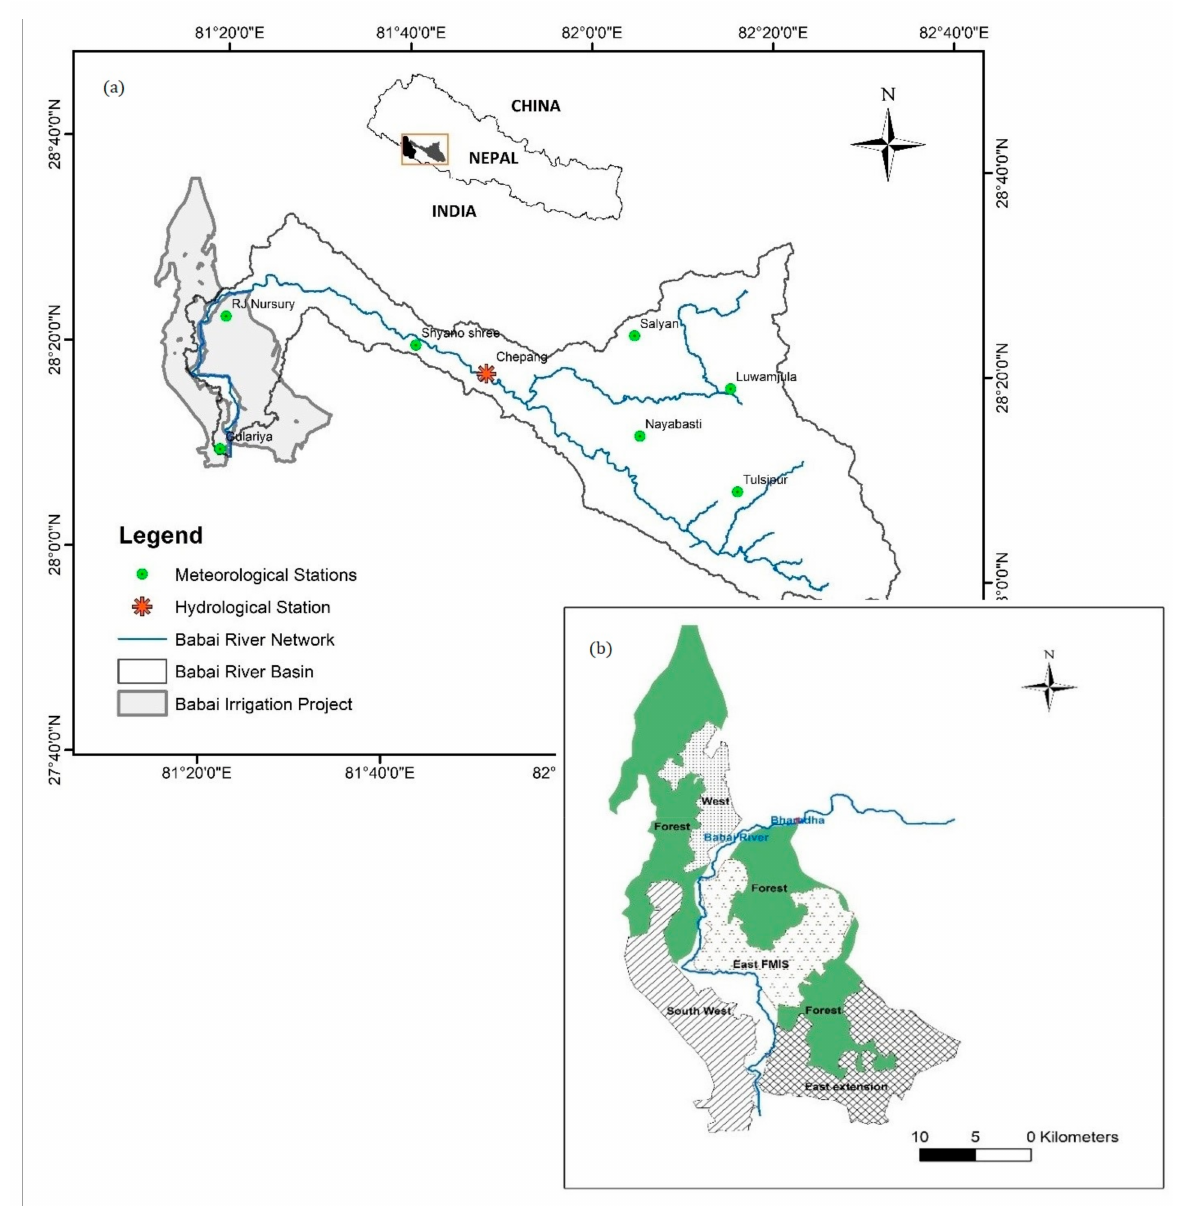
Figure 1. ( a ) Location of the Babai River Basin with its hydrological and meteorological stations (top) ( b ) Babai Irrigation Project